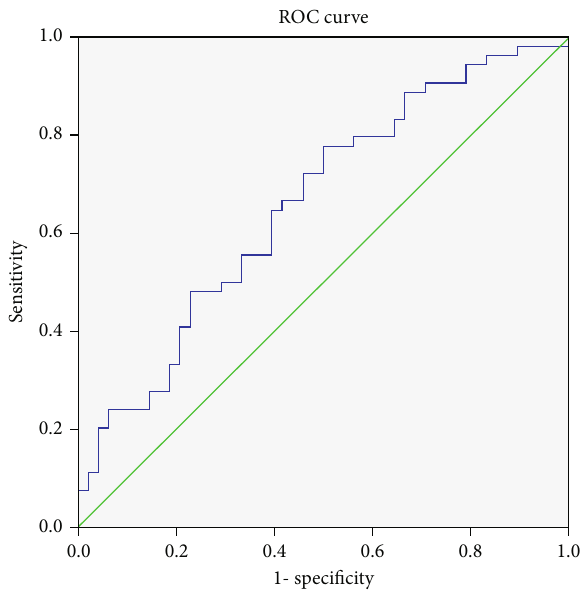
Figure 2: ROC curve of preoperative CSTB conveying in assessing the postoperative recurrence of bladder carcinoma.